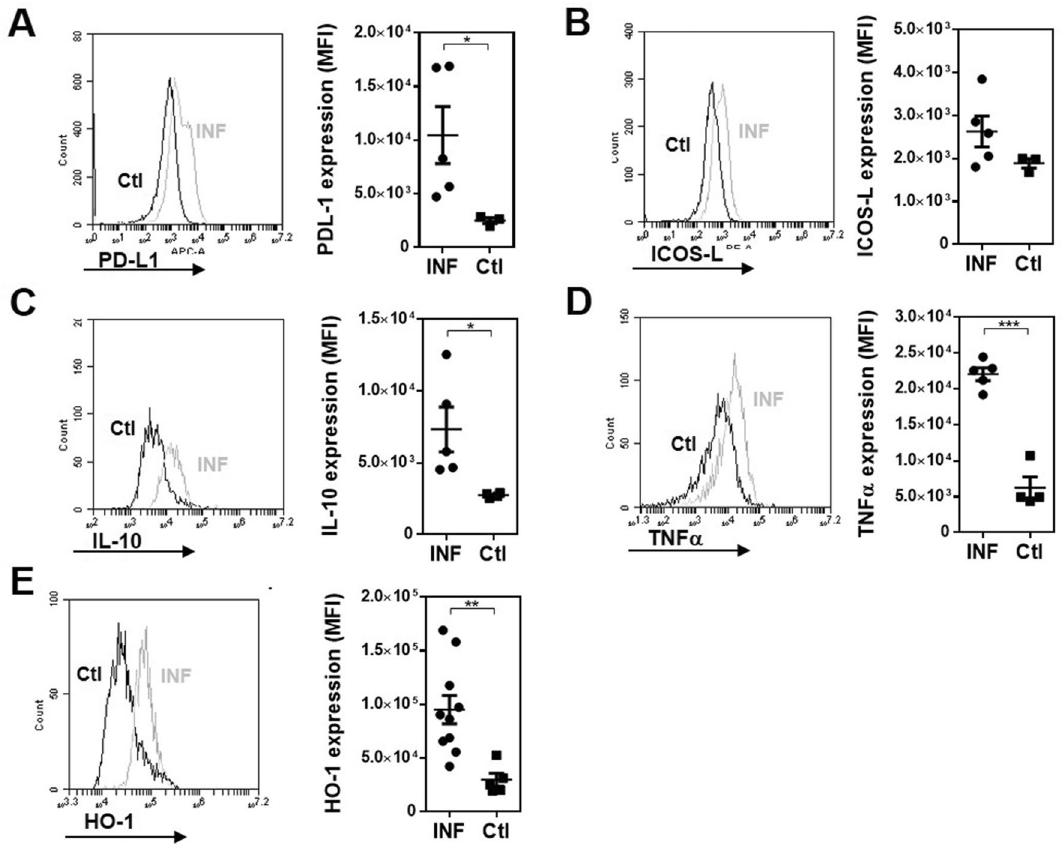
Figure 3. Peritoneal F4/80 + cells in F. hepatica MGL2-DTR mice express immunoregulatory molecules. Expression of PD-L1 ( A ), ICOS-L ( B ), IL-10 ( C ), TNFα ( D ) and HO-1 ( E ) is shown in F4/80 + peritoneal cells from F. hepatica infected mice (INF) and non-infected animals (Ctl). Grey lines in histograms represent infected mice while black lines indicated control mice. A representative figure of three independent experiments is shown (± SEM, indicated by error bars). Asterisks indicate statistically significant differences (* p < 0.05, ** p <